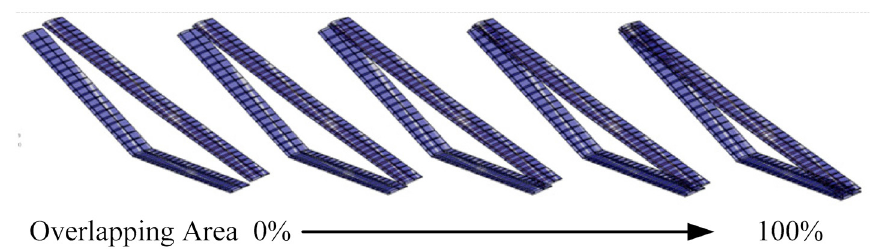
Figure 9. Proportion of overlapping